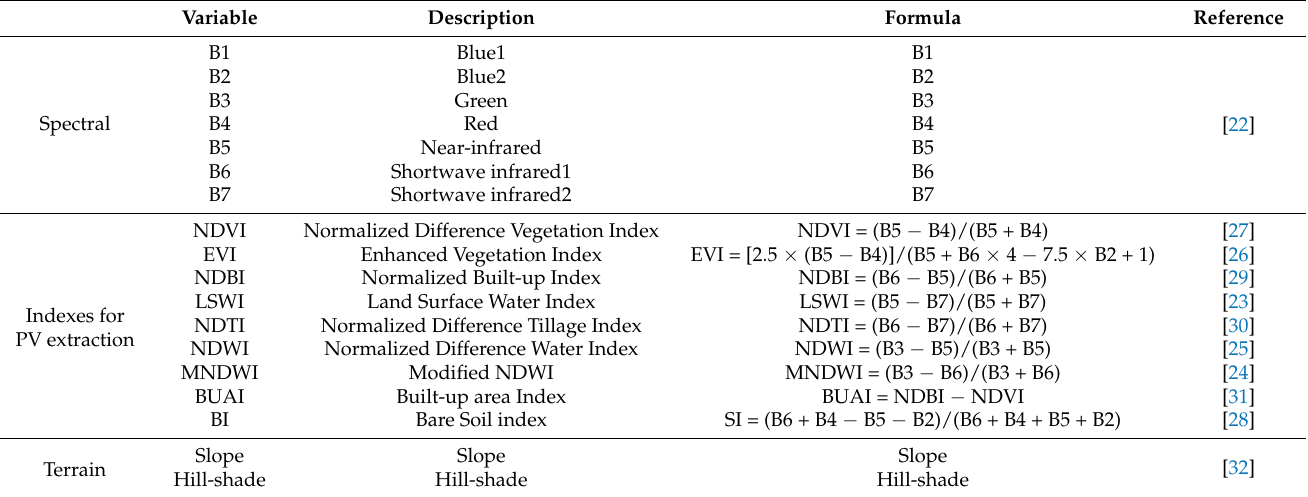
Table 2. Summary of the categories of variables used to classify PV plants in the study area.